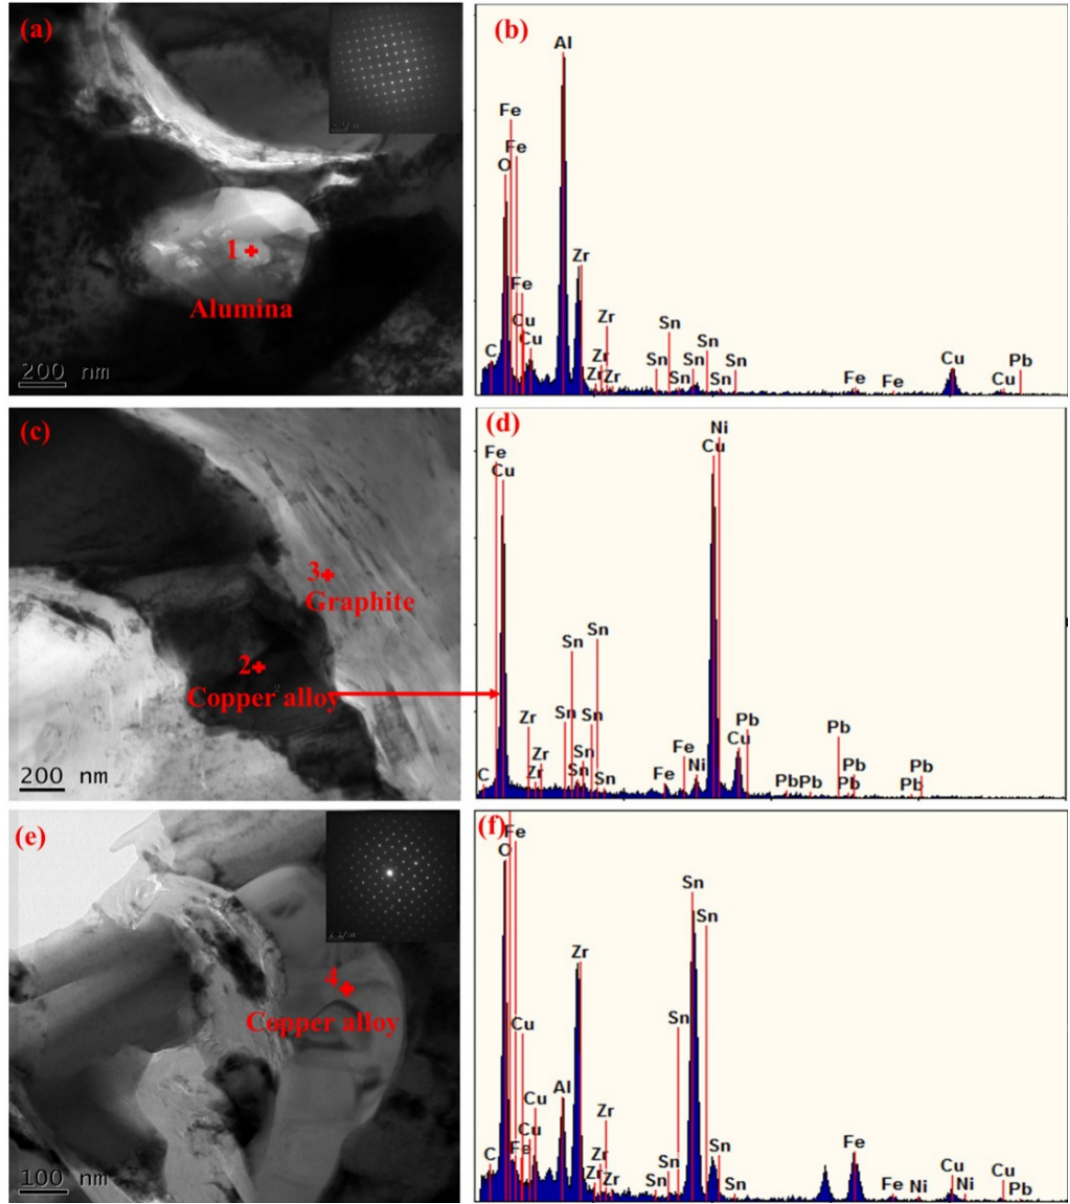
Figure 7. TEM images of sintered composites with 0.5 wt %alumina whiskers: ( a ) TEM bright field images, corresponding selected-area electron diffraction pattern obtained from point 1 shown in the upper right panel; ( b ) EDS analysis at point 1; ( c ) TEM bright field images; ( d ) EDS analysis at point 2; ( e ) TEM bright field images, corresponding selected-area electron diffraction pattern obtained from point 4 shown in the upper right panel; ( f ) EDS analysis at point 4.